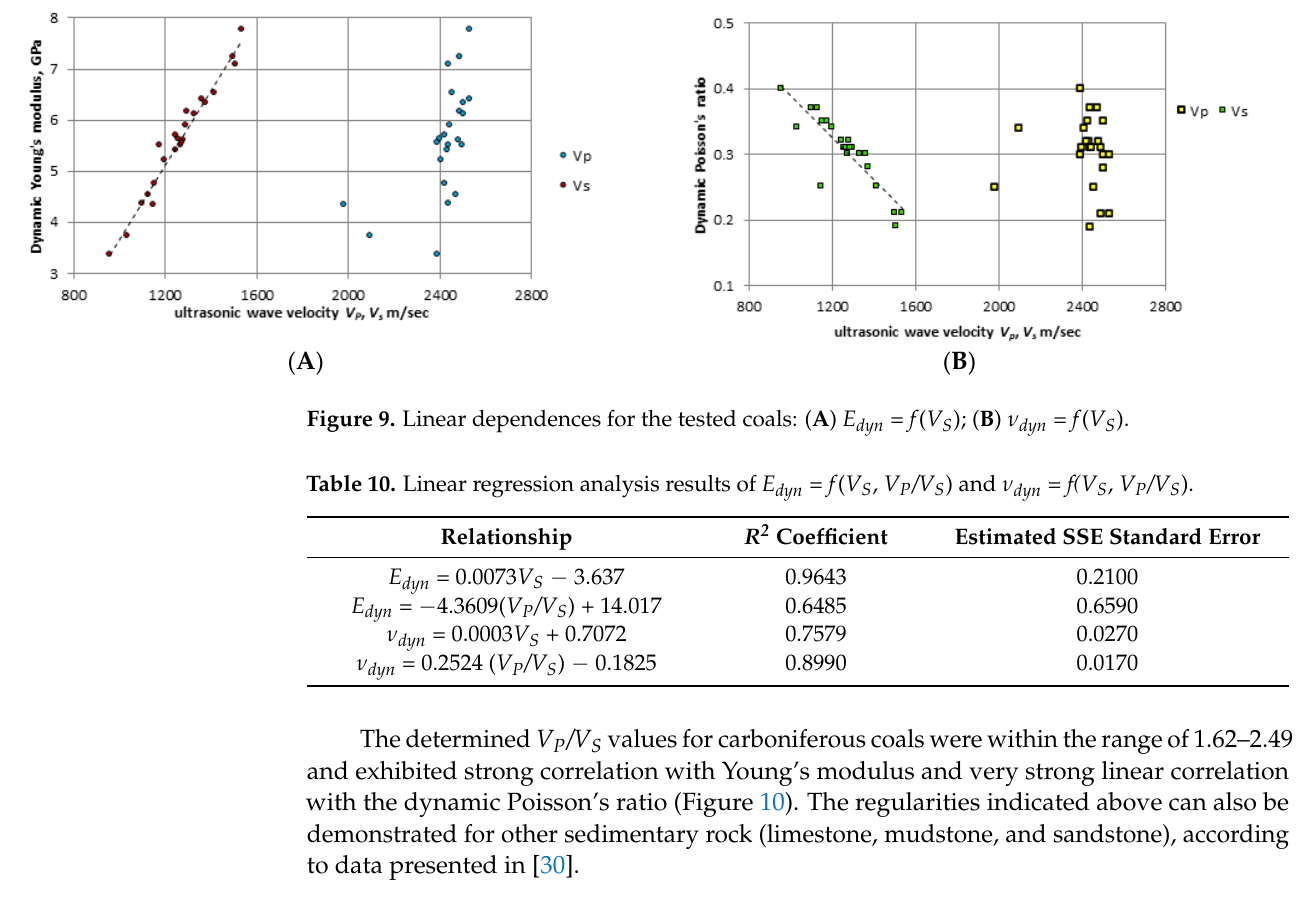
Figure 8. Mean petrophysical dynamic parameter of the tested coals.